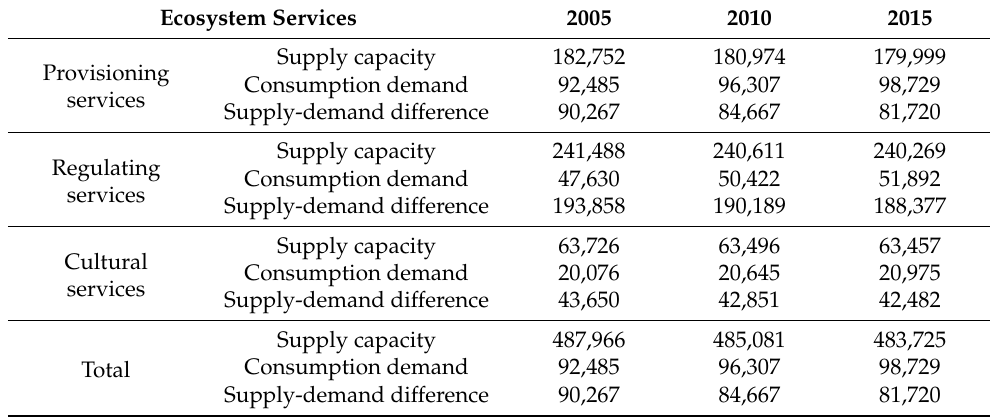
Table 6. The change in supply and demand of ecosystem services in Quanzhou (dimensionless). Ecosystem